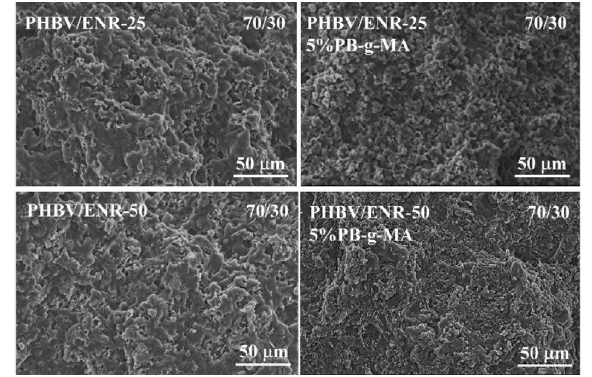
Figure 9. SEM micrographs of fractured surfaces of PHBV/ENR-25 and PHBV/ENR-50 blends with and without